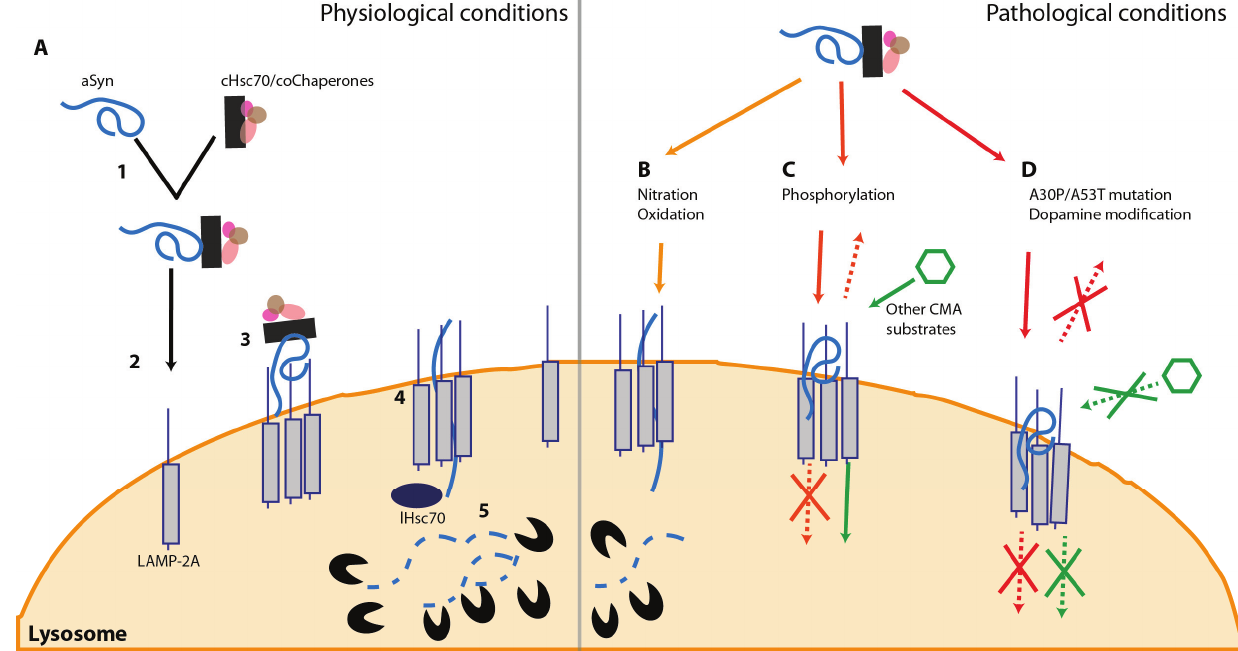
Figure 1. (cid:2)-syn and the CMA. ( A ) Under physiological conditions, Hsc70 recognizes the KFERQ domain of (cid:2)-syn (1) and targets the protein towards the lysosome (2). At the lysosomal membrane, (cid:2)-syn interacts with LAMP-2A and promotes its oligomerization (3) leading to the entrance of the protein into the lysosome (4). Once inside the lysosome, (cid:2)-syn is degraded by proteases (5); ( B ) PTMs such as oxidation and nitration slightly inhibit this pathway and reduce (cid:2)-syn degradation; ( C ) Phosphorylation of (cid:2)-syn on S129 impairs its degradation via CMA. However, while the phosphorylated form of protein does not block this pathway ( D ), dopamine-modified (cid:2)-syn and some familial mutations (A30P and A53T) that are also not degraded via CMA, can block this pathway and prevent the degradation of other CMA